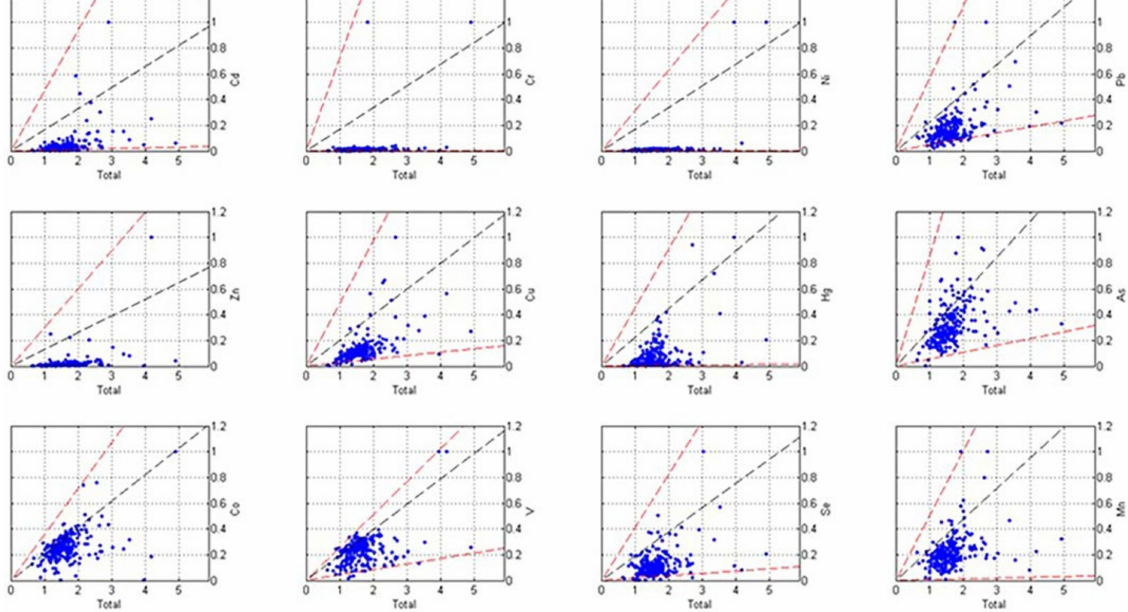
Figure 6. Geometric distribution diagrams of the heavy metal